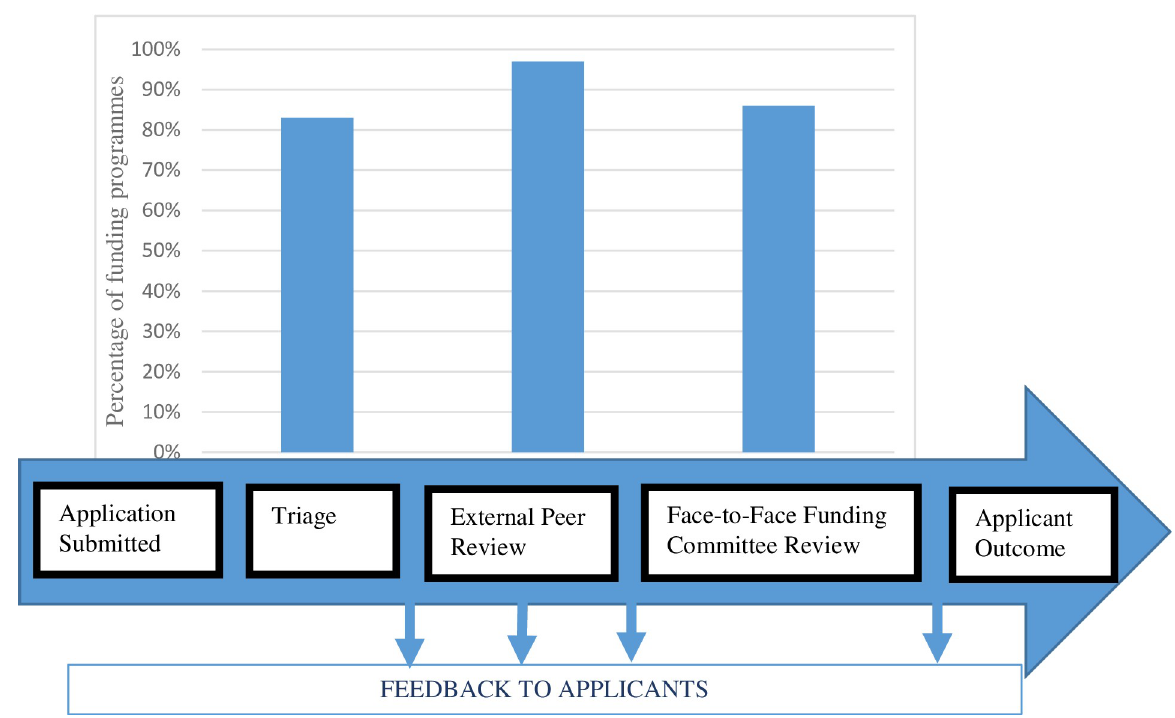
Fig 2. A typical decision-making pathway and percentage of respondents that use the process. Total number of survey responses = 29 (two entries were blank so not included in